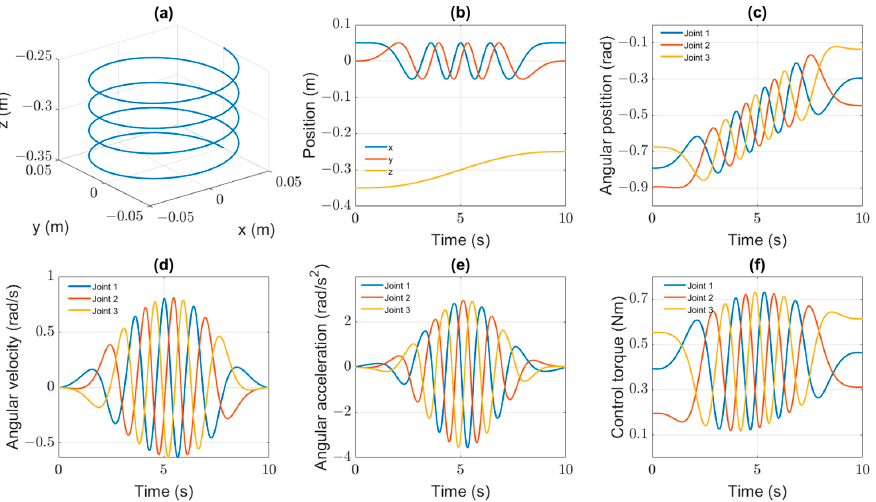
Figure 3. Helix trajectory characteristics: position transitions in workspace ( a ), versus time ( b ); in joint space ( c ), angular velocities ( d ); angular accelerations ( e ); torques of delta manipulator ( f ).